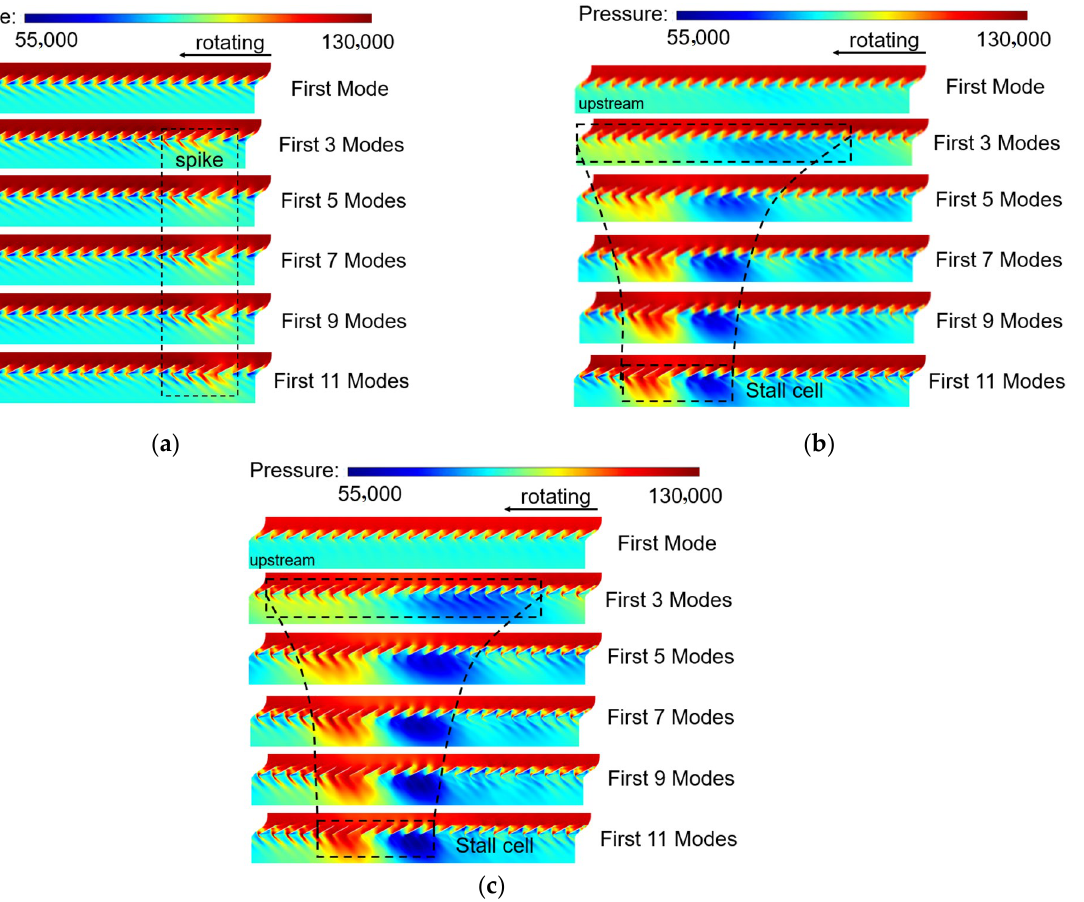
Figure 9. Reconstruction results. ( a ) Pre-stall stage reconstruction. ( b ) During-stall stage reconstruction. ( c ) Stable-stall stage reconstruction.